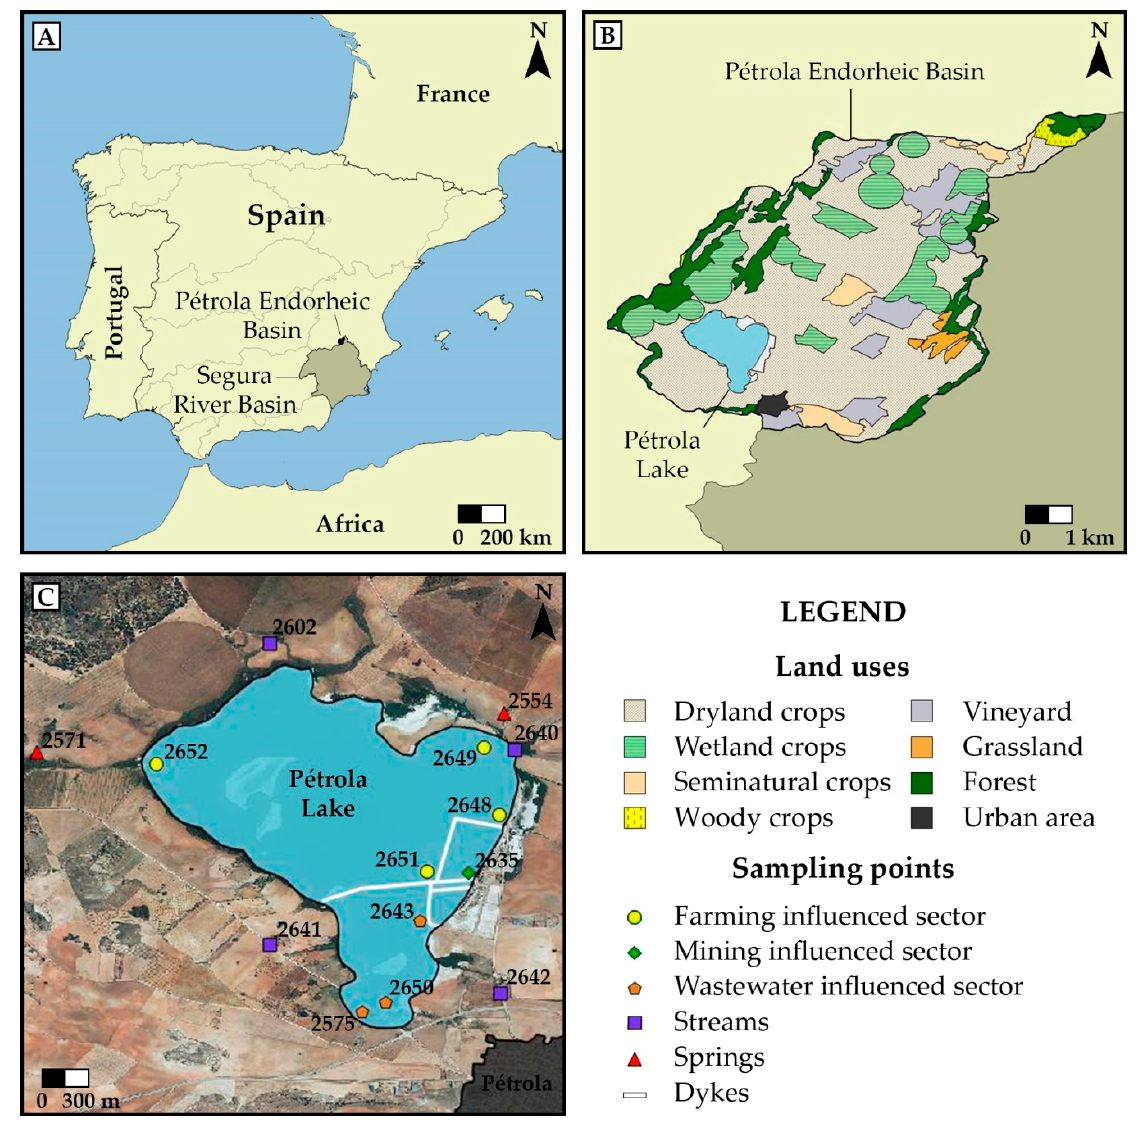
Figure 1. ( A ) Location of Pétrola lake at Segura River Basin in Spain. ( B ) Delimitation of Pétrola endorheic basin (data from Ministry for Ecological Transition and Demographic Challenge) and main land uses present in the study area (data from CORINE Land Cover, 2018). ( C ) Location of the water sampling points in the Pétrola Lake area.